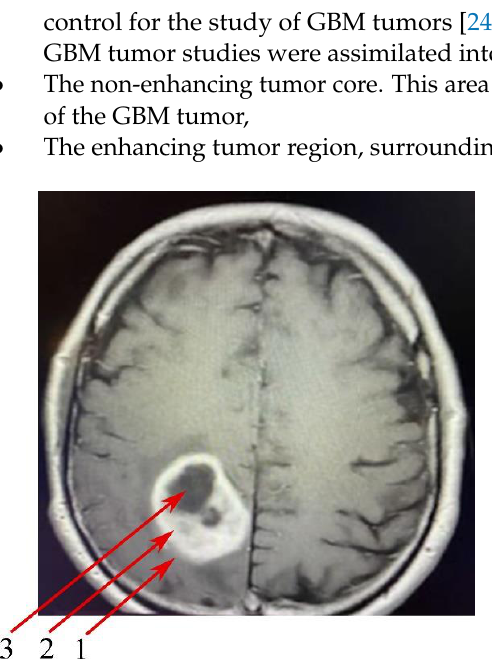
Figure 2. Magnetic resonance imaging (MRI) scan of the brain with the glioblastoma multiforme (GBM) tumor. The image highlights the three study zones: (1) peritumoral area, (2) enhancing tumor region and (3) tumor core. Axial, T1-weighted MRI scans of a 64-year-old patient diagnosed with GBM in the right parietal lobe. The patient presented visual impairment in the left eye and visual-spatial coordination disorders, as well as a sensory impairment on the right side.